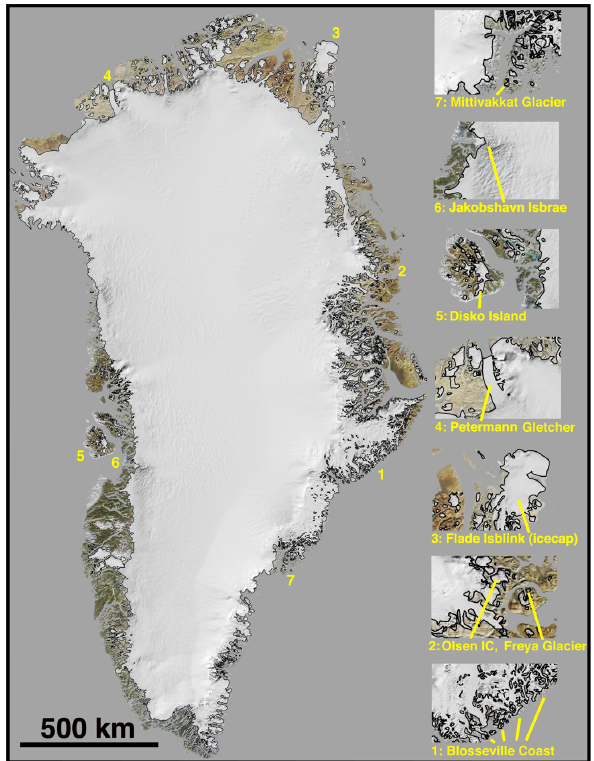
Fig. 1. Greenland ice outlines, simplified from outlines to be re- ported by Citterio et al. (2012), overlain on a 250 m MODIS mo- saic of Greenland made by Paul Morin. See Supplement Fig. S1 for a full resolution, unannotated version and further details. Insets highlight glaciers and icecaps discussed in the